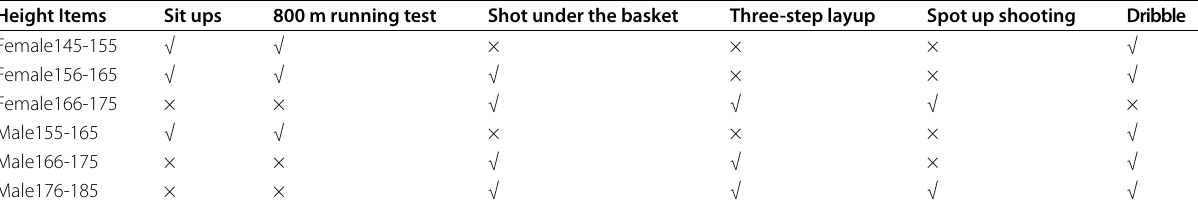
Table 1 Whether men and women of different heights are good at basketball activities Height Items